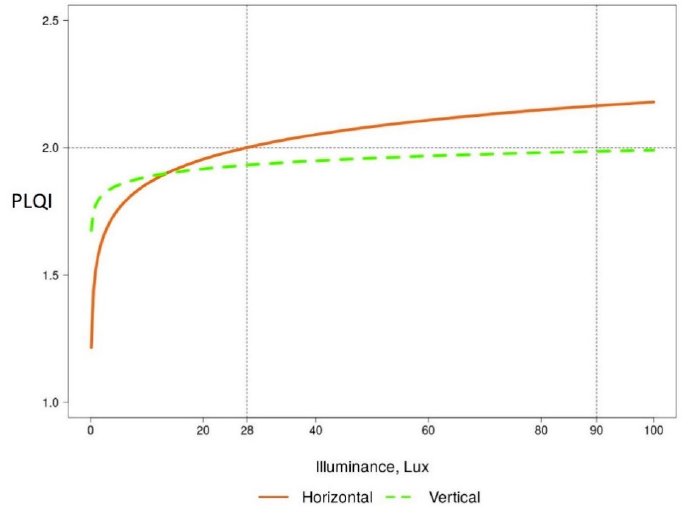
Figure 2. Model-response test of PLQI to plausible changes in horizontal and vertical illuminance